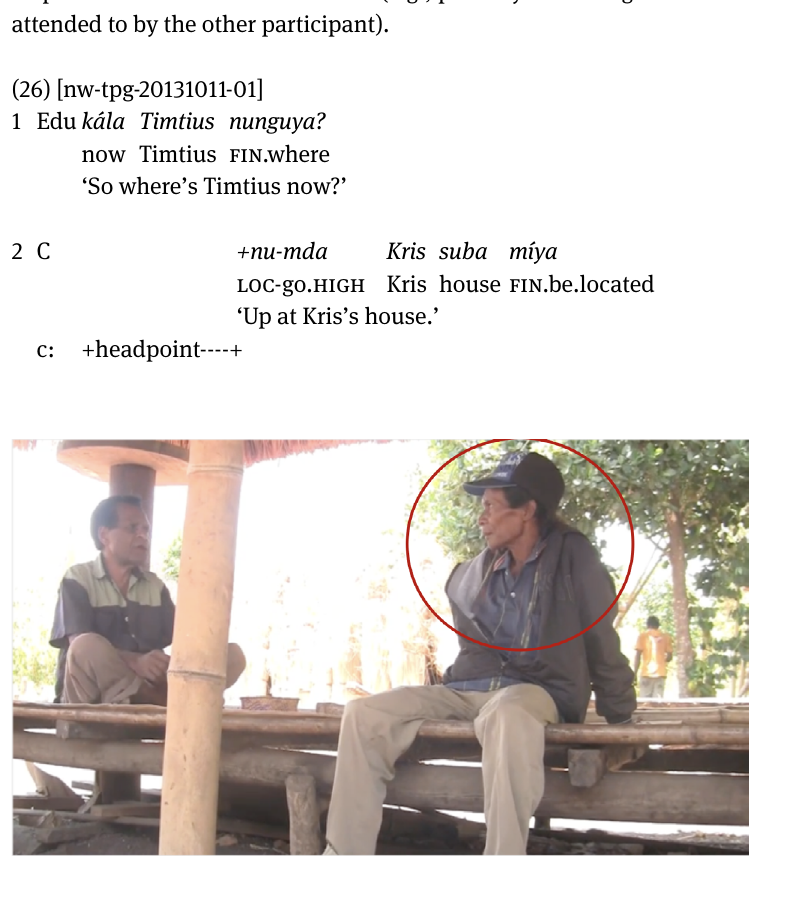
Figure 8. C’s position at line 1